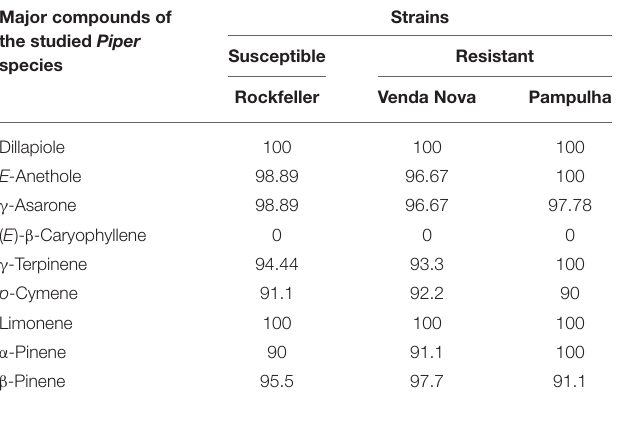
TABLE 7 | Percentage of dead larvae after 24h of exposure to major compounds of the studied Piper species at concentration 100 ppm.